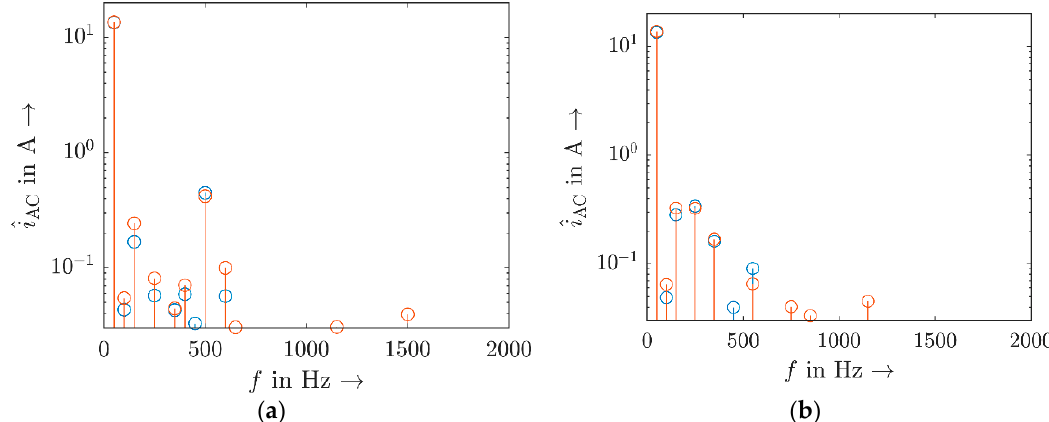
Figure 8. Amplitude spectrum î AC of measured grid-side current (red) and grid-side current simulated by ANN (blue) for